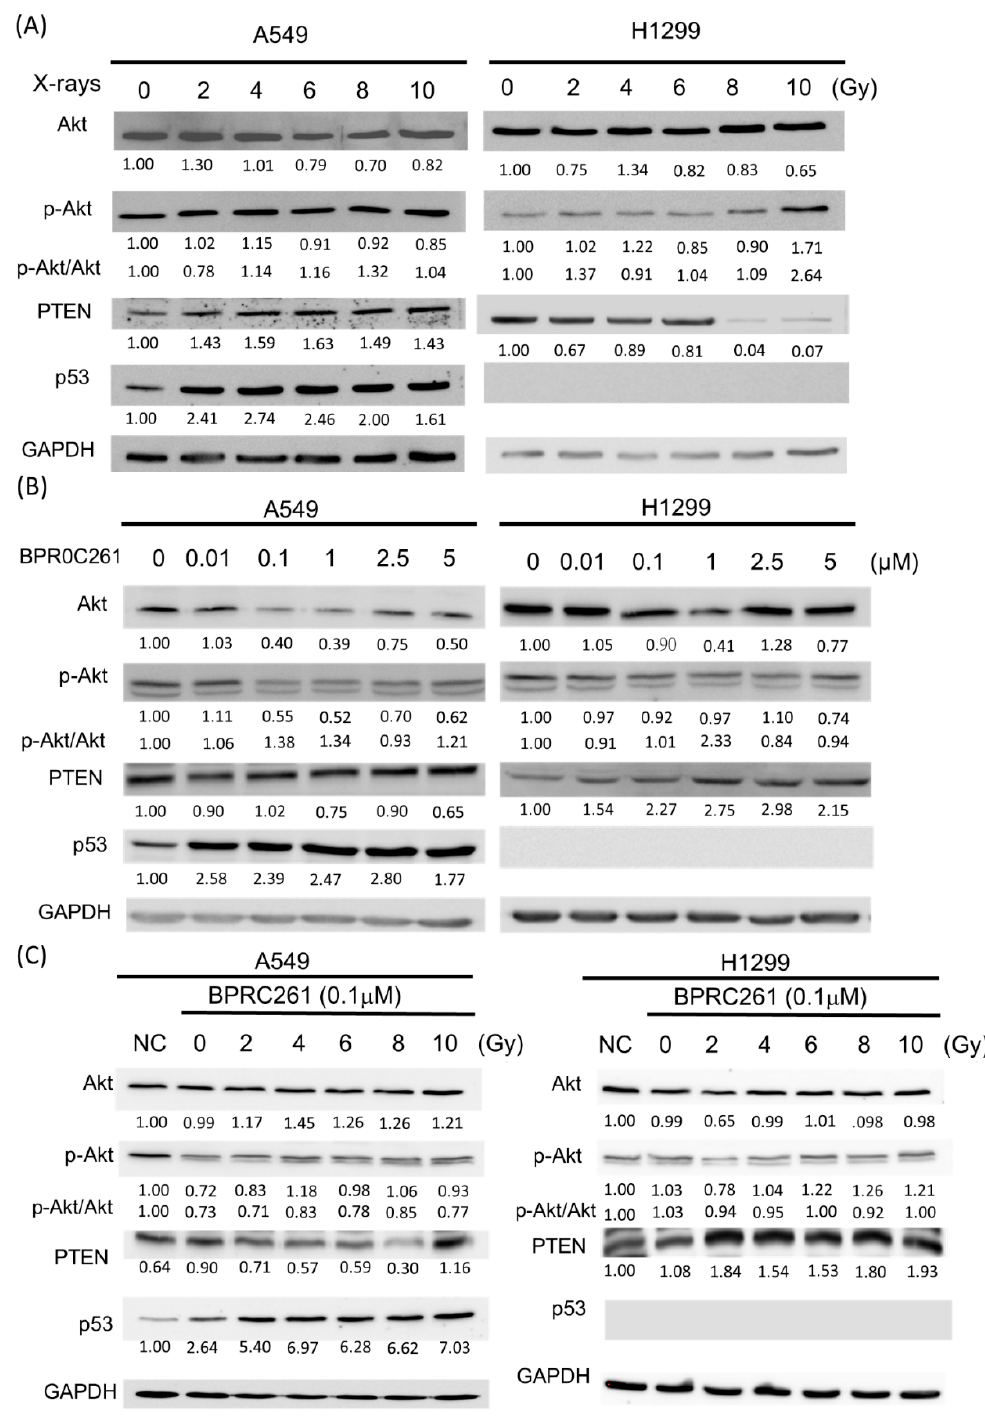
Figure 6. Expression of p53 and PTEN in NSCLC cells treated with BPR0C261 and radiation. ( A ) Western blot analysis of Akt, p-Akt, PTEN, and p53 in A549 cells and H1299 cells exposed to different doses of X-rays. ( B ) Same as ( A ) but treated with different concentrations of BPR0C261. ( C ) A combination of BPR0C261 and X-rays on the expression of proteins described above. NC is the negative control without treatment. The blots of Akt, pAkt, PTEN, and p53 were normalized to that of GAPDH, and then compared to untreated control or NC to determine the ratio of each treatment. The results are from three independent experiments.